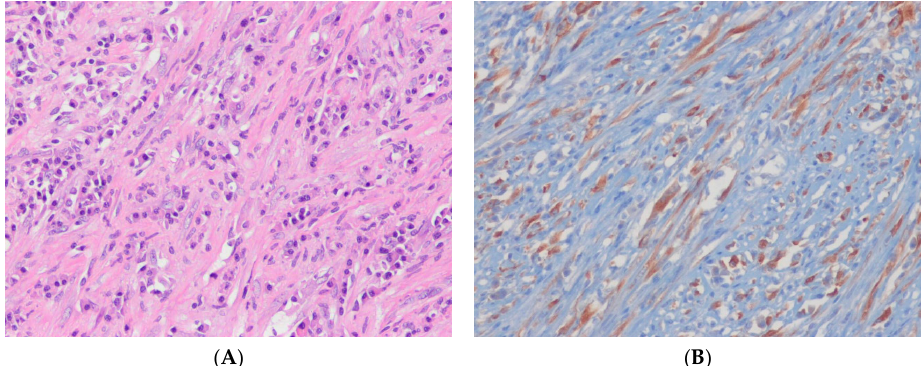
Figure 3. In fl ammatory myo fi broblastic tumor. ( A ) The tumor shows spindle cells with vesicular nuclei and eosinophilic cytoplasm admixed with lymphocytes and plasma cells (H&E stain, ×200). ( B ) The tumor cells show cytoplasmic positivity for ALK , indicating the presence of an underlying ALK rearrangement (immunohistochemical stain for ALK, ×200).